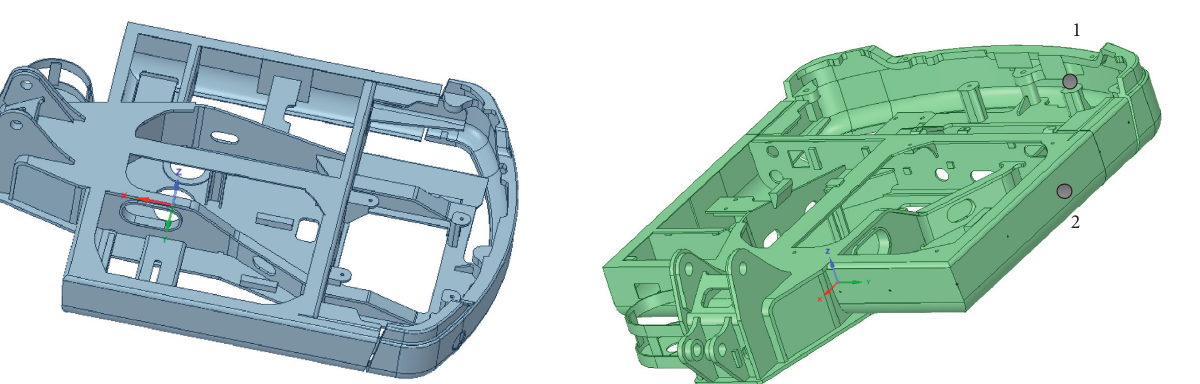
Figure 3: Three-dimensional model of the rotary platform. Table 1: Simulation results of the first four-order natural fre- quencies of the rotary platform.